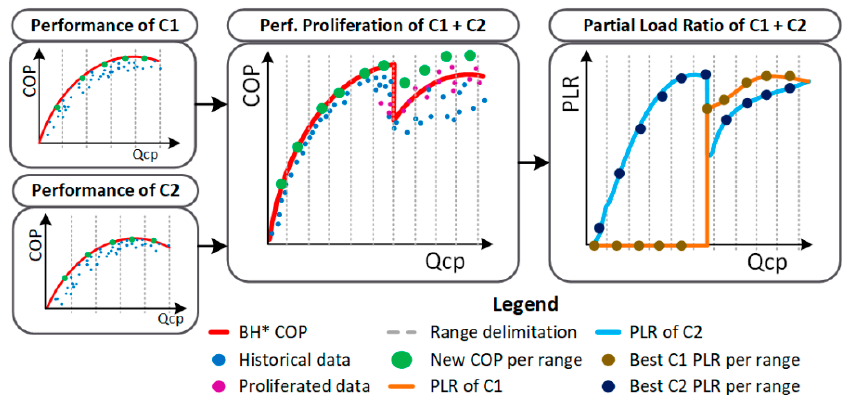
Figure 6. Proliferation steps in order to obtain a near-optimal PLR setpoint for each compressor in each specific operation conditions discretized by each best-matching unit (BMU). * BH stands for best historical performance.